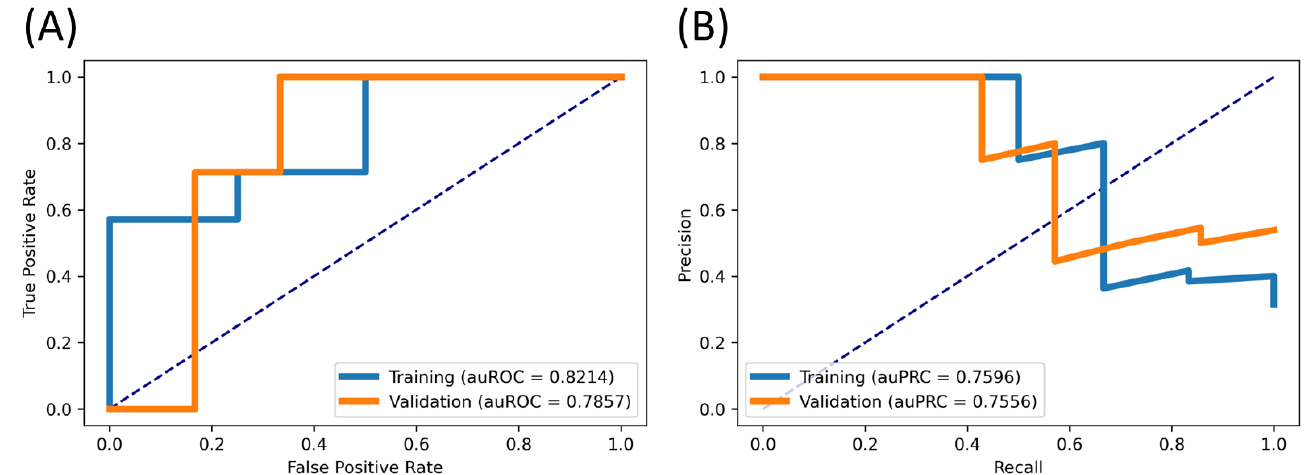
Figure 2. Comparative performance between training and validation data. ( A ) ROC curve, ( B ) PR